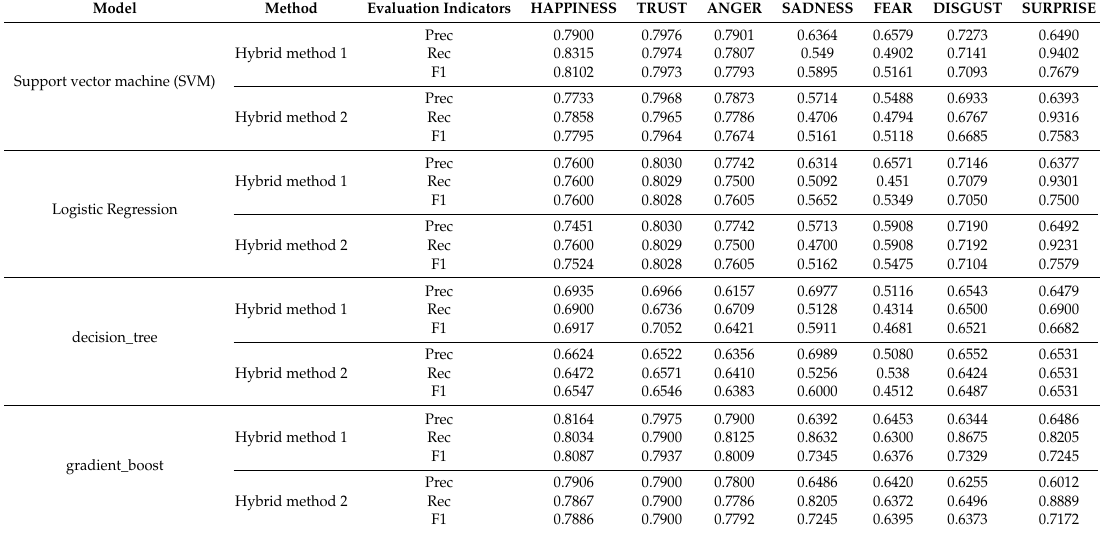
Table 4. Performance evaluation sentiment-aware word embedding. Hybrid method 1 is as shown in Equation (6), hybrid method 2 is as shown in Equation (8), Prec is the abbreviation of Precision which is as shown in Equation (9), Rec is the abbreviation of Recall which is as shown in Equation (10), F1 is the abbreviation of F-measure which is as shown in Equation